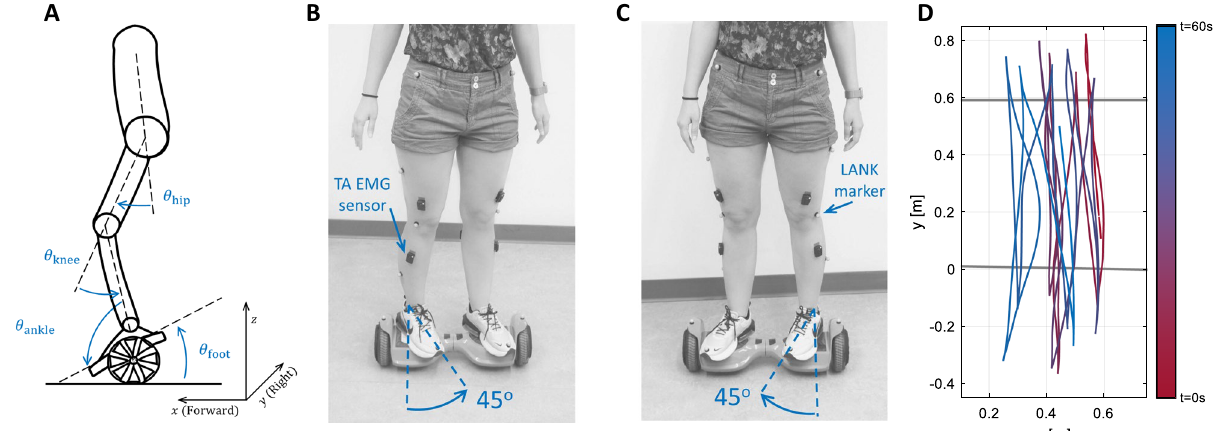
Figure 1. ( A ) Schematic of the joint angles and the hoverboard plate orientation (side view). ( B ) The feet ◦ are oriented 45 to the left of the hoverboard, corresponding to conditions A1 and A2. ( C ) Feet orientation in condition B. ( D ) Movement trajectory in the x-y plane from a representative participant #9 in condition A2. The line color (from red to blue) indicates the time. Grey lines indicate the goal lines participants had to Maintaining balance on a hoverboard is similar to stabilizing a cart-pendulum system 19 . Compared to quiet standing where the COG is kept within the base of support using ankle or hip strategies, the COP on the hover- board is not directly controlled by the user. Instead, it is indirectly manipulated by the tilt angles of the hover- board plates. As the user tilts the plates, the motors activate and rotate, generating a torque on the hoverboard’s wheel resulting in hoverboard translation. The user exploits this feature to perform goal-driven movements and to maintain balance, which is achieved by moving the base of support, a narrow area comprising the ground contact area of the two wheels that contains the COG. While balancing on a hoverboard or on the firm ground may appear to be very different in terms of control, in both cases, the COG can be controlled by dorsiflexion/ plantarflexion of the ankle, by flexion/extension of the hip or a multi-joint strategy 12 . The feet also remain stationary during both hoverboard standing and quiet standing, and in both situations either the tilt position (in hoverboard riding) or the applied torque (in quiet standing) must be regulated to maintain balance. Due to these similarities, the same terms of the ankle and hip strategies for hoverboard balance control are used in this paper. Each of these strategies is defined by which joint contributes more dominantly to the control of the orientation of the hoverboard plates. Riding a hoverboard and performing goal-driven movements is, nevertheless, more complicated than quiet standing. For instance, a hoverboard rider has numerous degrees of freedom in moving the hoverboard forward or backward (including variations in the velocity and the trajectory of the hoverboard). This could lead to a variety of strategies for performing the motion while maintaining balance. This makes the hoverboard control a challenging and interesting motor control task, in which we can analyze the lower limb motor learning in first-time riders and investigate if a general control strategy emerges and if a specific group of muscles would be recruited for this task. The specific aims of this study are to (1) investigate if early motor learning in a novel